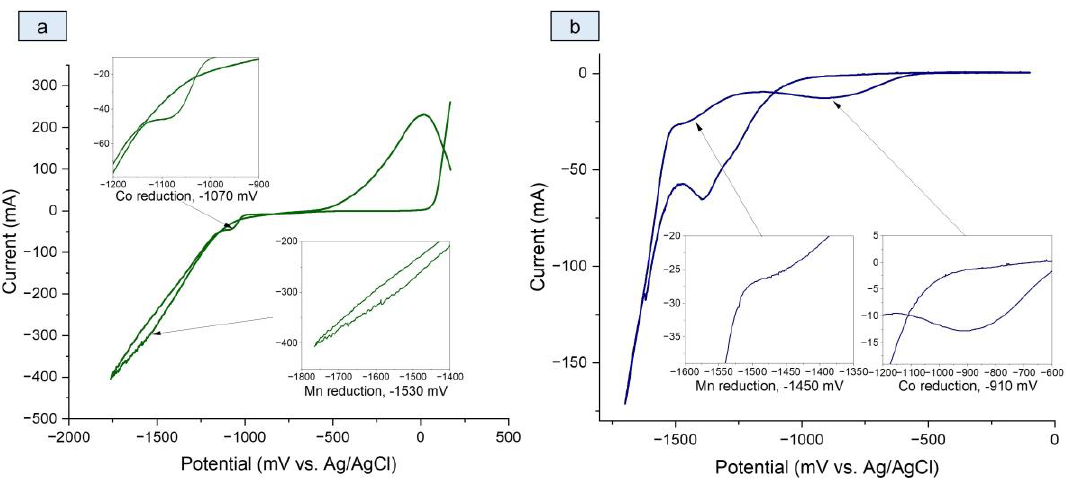
Figure 1. Cyclic current–voltage curves of electrolytes containing ions of cobalt and manganese sulfates ( a ) and cobalt and manganese sulfates with the addition of 10 wt % DMSO ( b ).